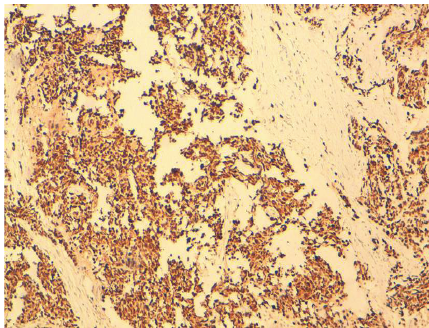
Figure 8: CT-scan-guided TCB slide of a pancreatic mass in a 56- year-old man. Immunohistochemical features at higher magnifica- tion view: a variable number of tumor cells expressed KI67 on